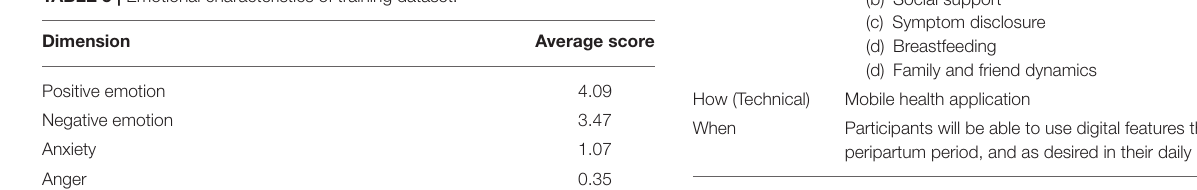
TABLE 5 | Emotional characteristics of training dataset.